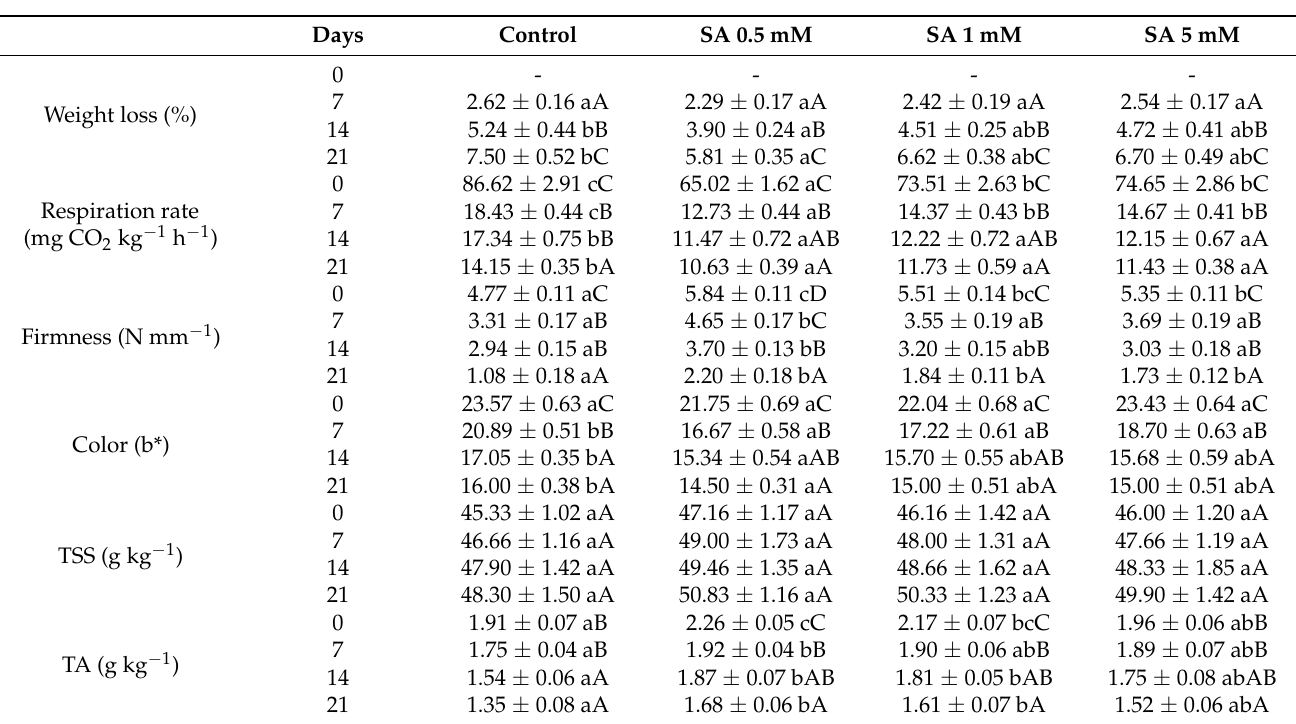
1 Values (mean of three replicates) ± SE followed by different lowercase letters, within the same row, show significant differences ( p < 0.05) among treatments, according to Tukey’s HSD test, for each parameter. Different capital letters in the same column show significant differences among storage days for each treatment at p <